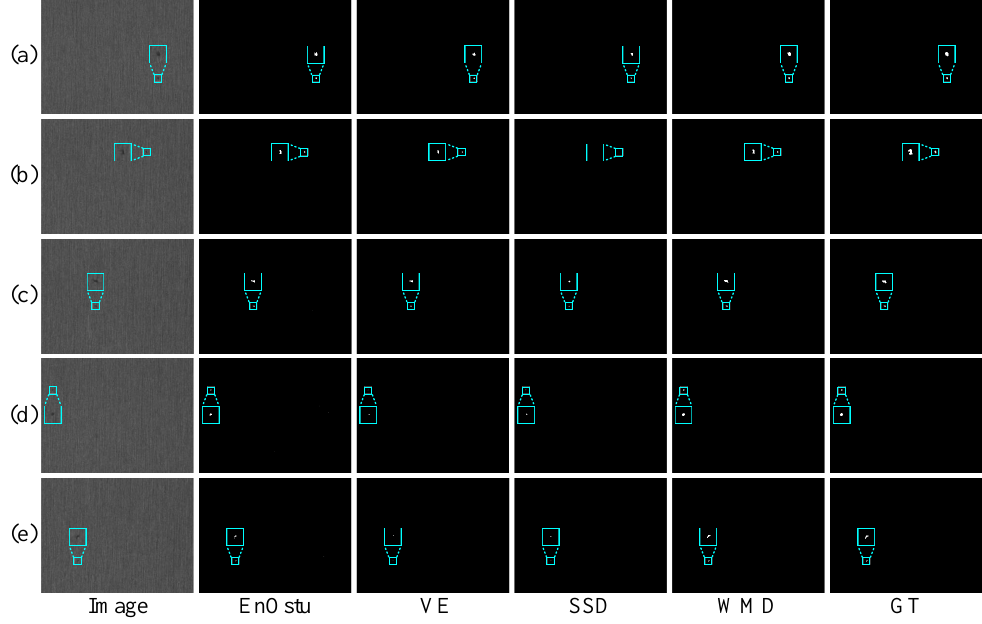
Figure 16. Visual comparisons of different methods on ( a – e ) five randomly selected single-defect images. The ground truth (GT) is shown in the last column. EnOstu, VE, SSD, and our method (WMD) have the ability to locate the